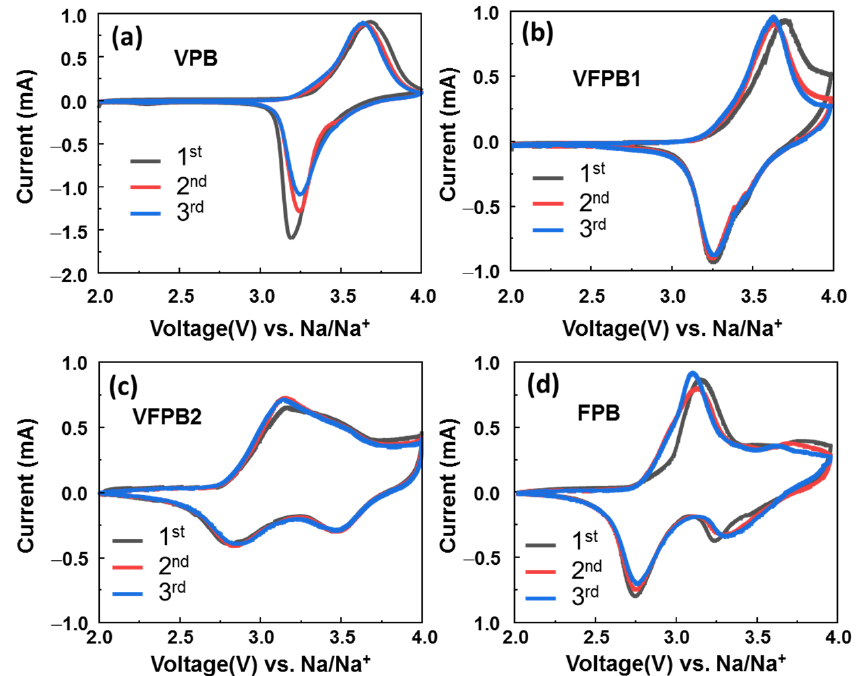
Figure 3. Cyclic voltammetry (CV) profiles of the first three cycles of ( a ) VPB, ( b ) VFPB1, ( c ) VFPB2, and ( d ) FPB cathodes.